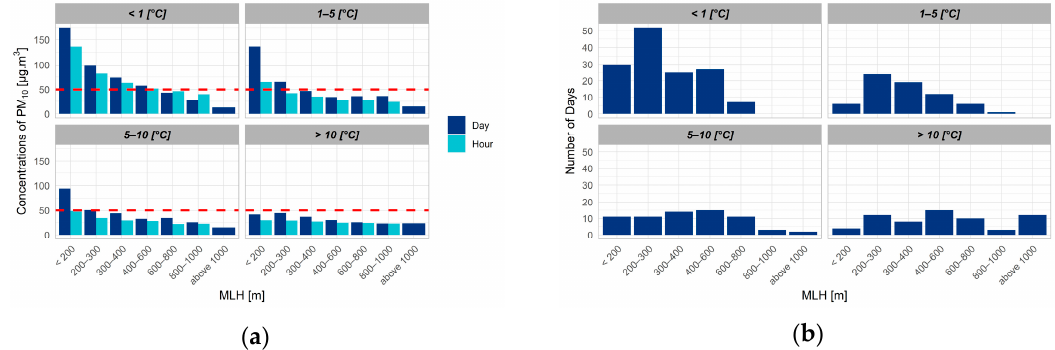
Figure 9. The Vˇeˇrˇnovice site, 2016–2019: ( a ) Average PM 10 concentrations depending on the mixing layer height and temperature; ( b ) Exceedance count of daily concentrations of 50 µg.m − 3 depending on the mixing layer height and temperature.